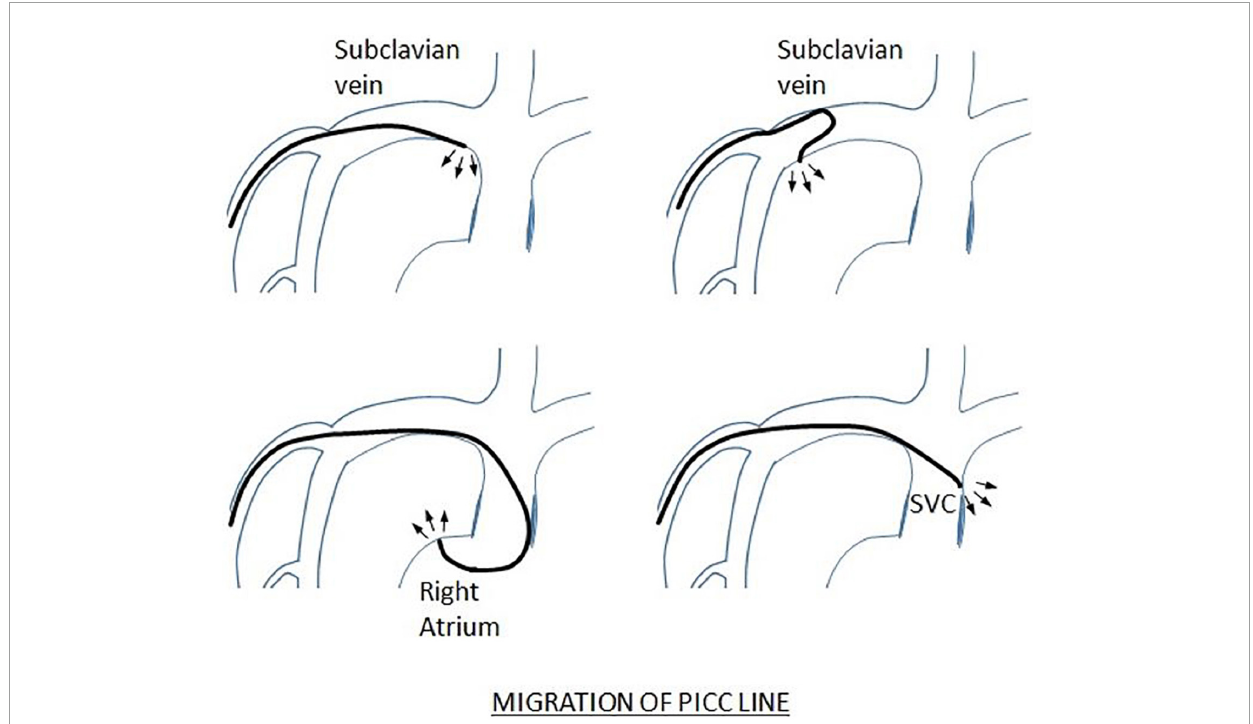
FIGURE3 Peripherally inserted central catheters migration leading to vascular perforation. One of the potential etiologies behind pericardial and pleural effusions is chronic friction resulting in vascular wall compromise and ultimate perforation. As the line migrates, the catheter tip might meet the continuously moving vessel wall. Subclavian vein, superior vena cava and the right atrium are potential sites of injury. The thin vascular walls, and the rapid heart rate contribute to increased frequency and impact of friction. The angle formed by the line and vascular wall is important. When the angle is relatively perpendicular, direct vessel trauma and erosion occur, leading to thrombus formation and further catheter adherence to the vascular structure. Eventually, erosion is potentiated, which might lead to preformation and fluid accumulation in the pericardium (35).